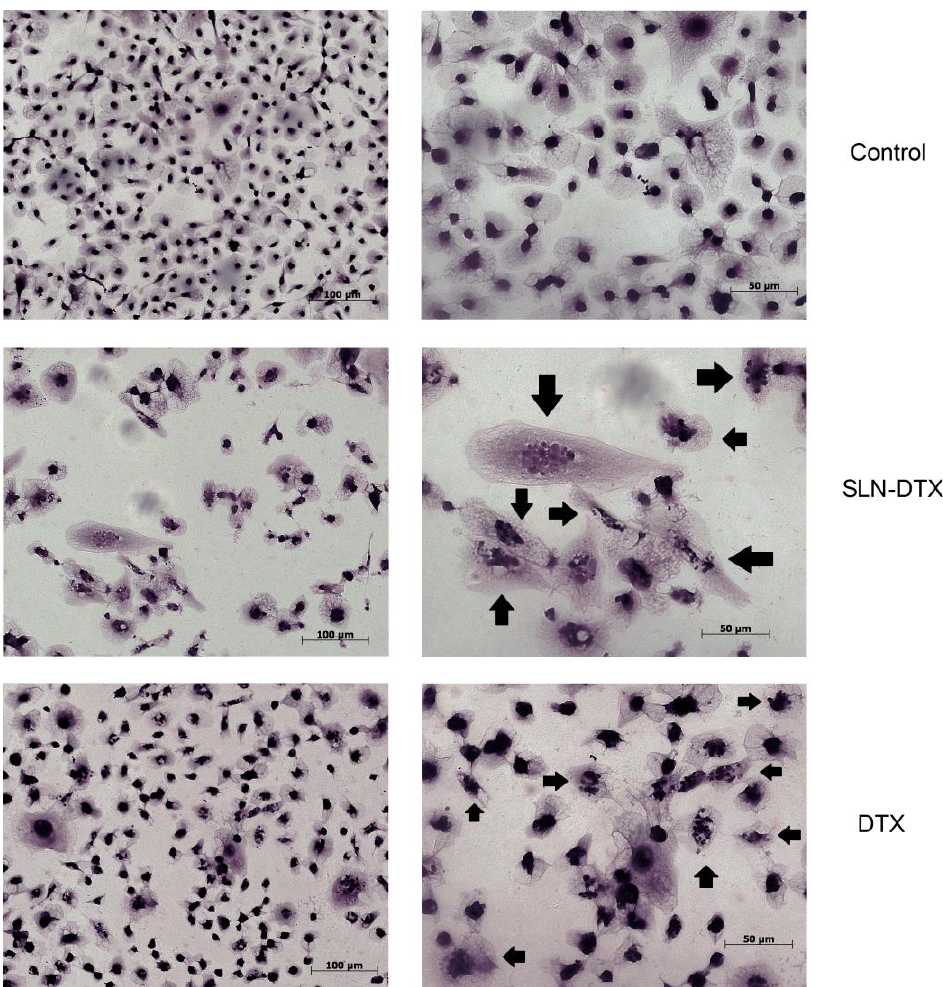
Figure 3. Morphological evaluation of the MDA-MB-231 cell line stained with hematoxylin and eosin after 72 h of treatment with SLN-DTX and DTX observed by light microscopy. Arrows indicate cells that show the altered nucleus, with multinucleation in both treatments.